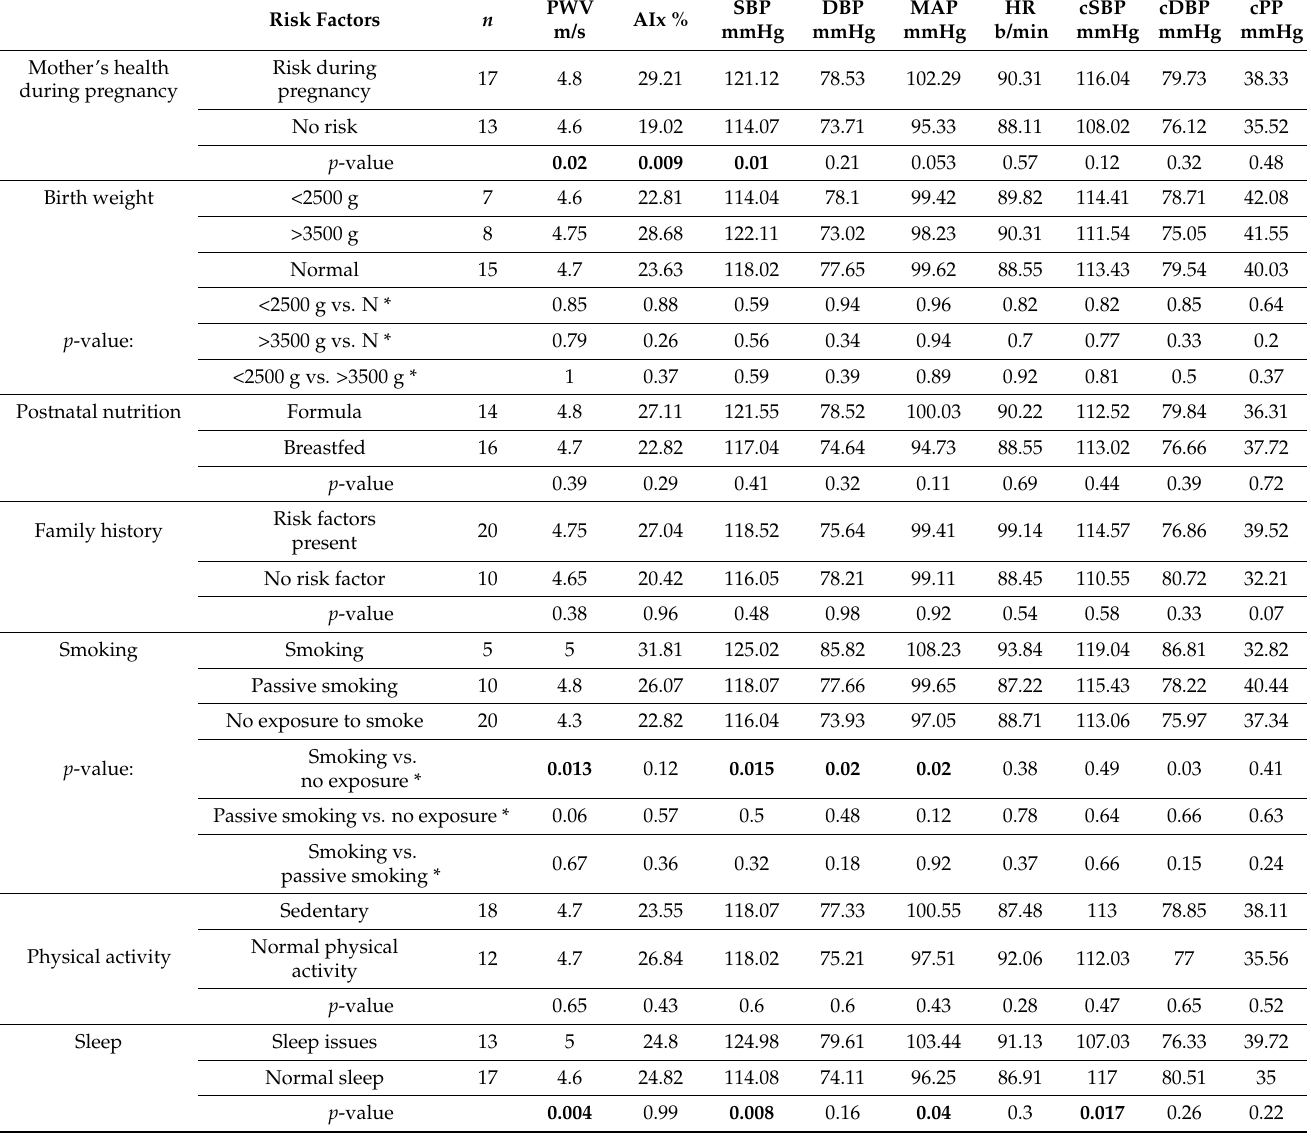
Table 14. PWA parameters comparison of mean/median values depending on the presence of risk factors in the obese group ( t -Student tests and Mann–Whitney tests, after checking each parameter’s normality of distribution).